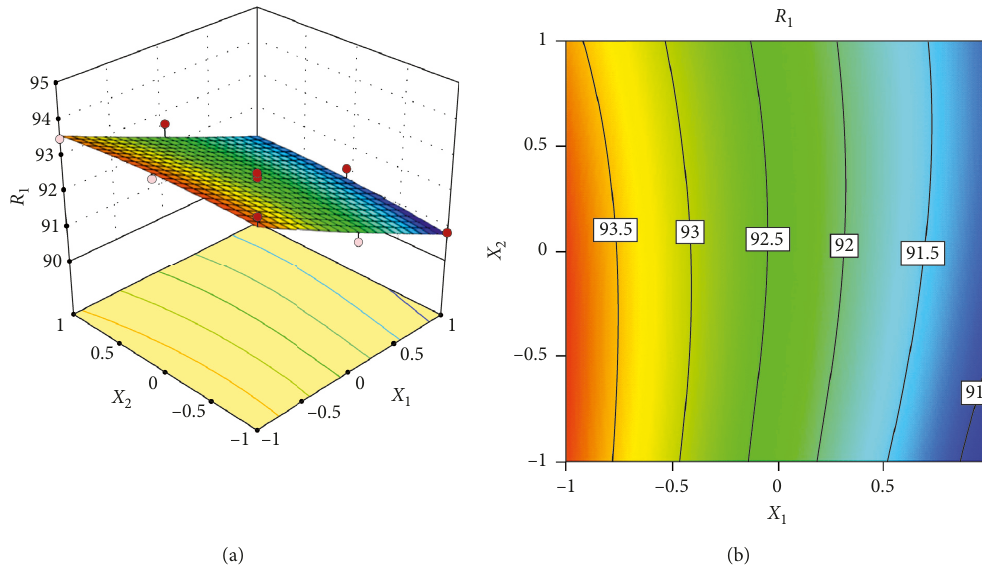
Figure 3: Response surface plot and contour plot showing the effect of independent variables X